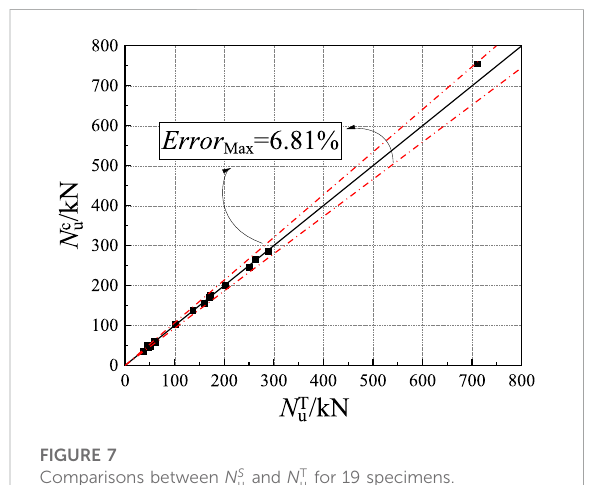
FIGURE 7 Comparisons between N S u and N T u for 19